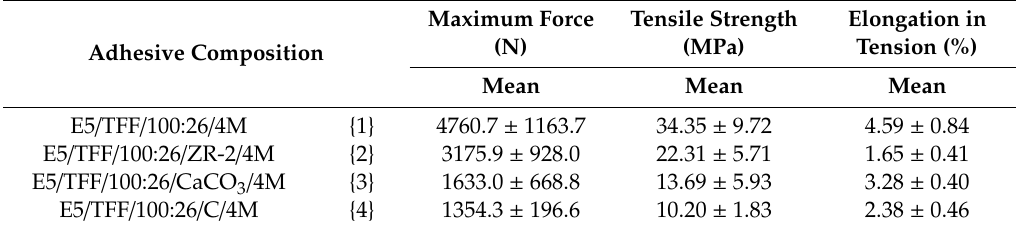
Table 9. Strength test results of the adhesive compositions from the E5 / TFF / 4 month group.